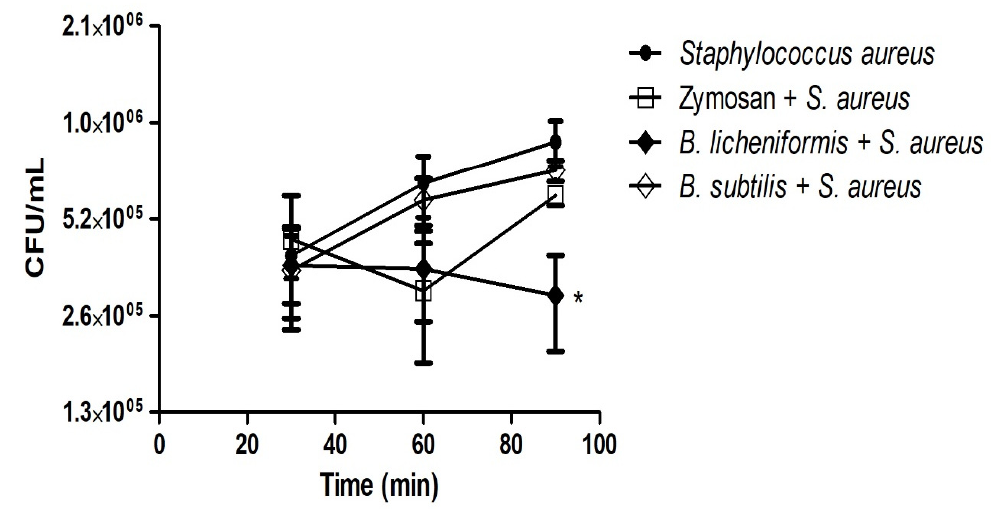
Figure 4. B. licheniformis reduces the CFU/mL of Staphylococcus aureus. The formation of METs was induced in macrophages infected with Bacillus species for 1 h. The METs formed were challenged with S. aureus for 30, 60, and 90 min. The CFU/mL of S. aureus were determined. The repeated measures ANOVA test was performed, followed by a post hoc t -test with a Bonferroni correction. * p < 0.05.